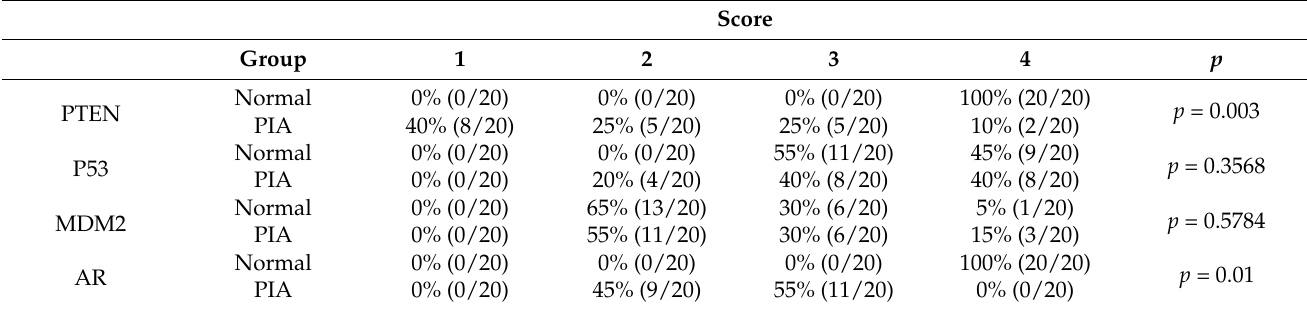
Table 1. PTEN, P53, MDM2 and AR immunohistochemical expression in canine normal prostate and PIA